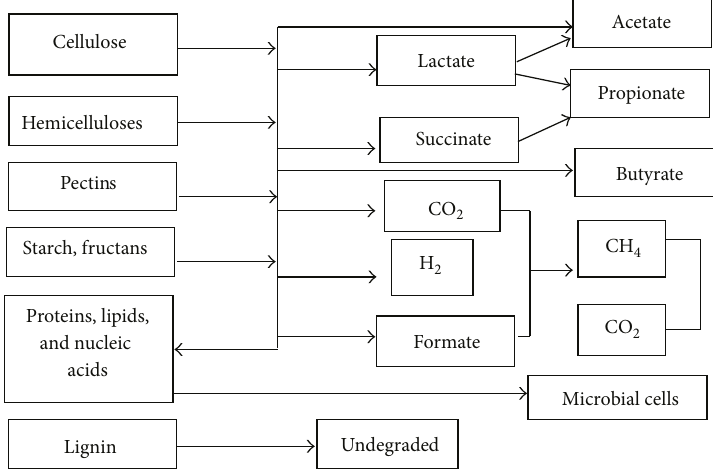
Figure 3: General scheme of biopolymer fermentation in the rumen. Products in boxes with darker borders are final products of the ruminal fermentation, while compounds in light-bordered boxes are intermediates